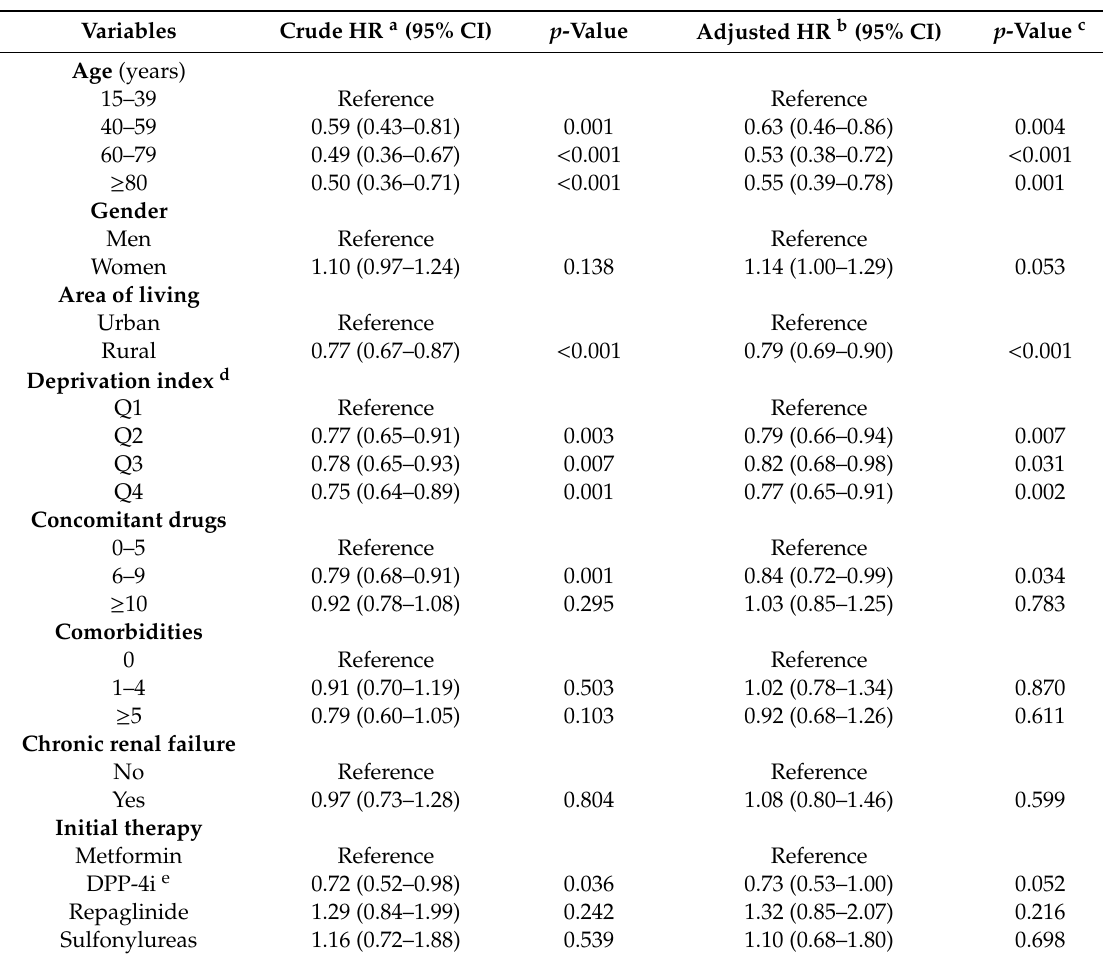
Table 4. Predictors of treatment discontinuation to initial antidiabetic therapy at one year post-initiation (objective